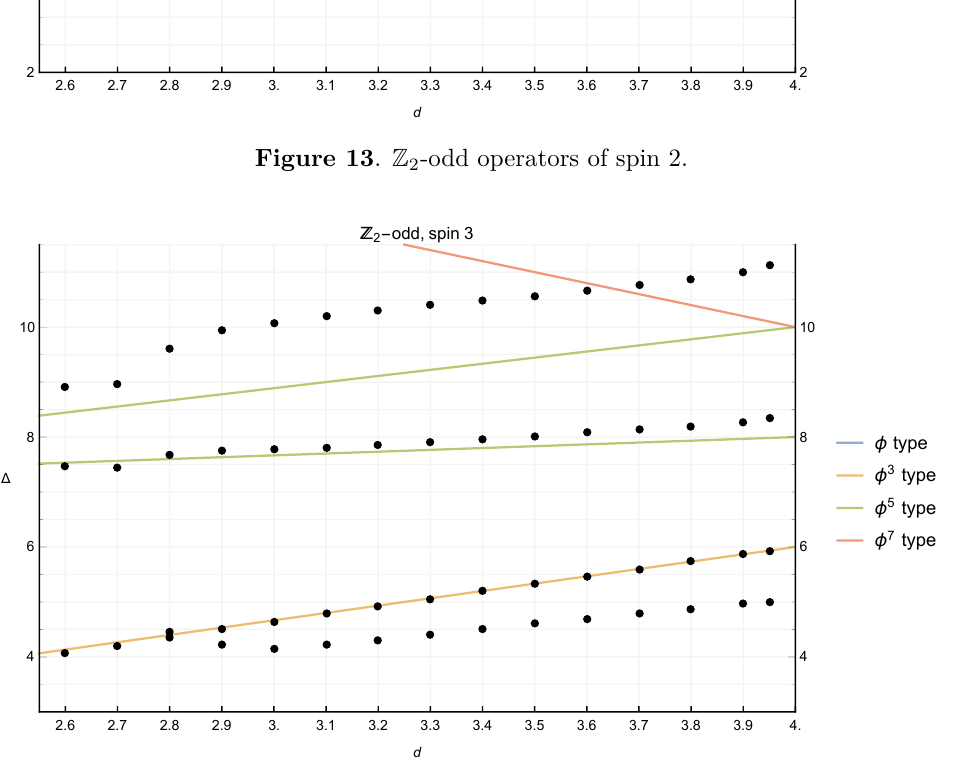
Figure 14 . Z 2 -odd operators of spin